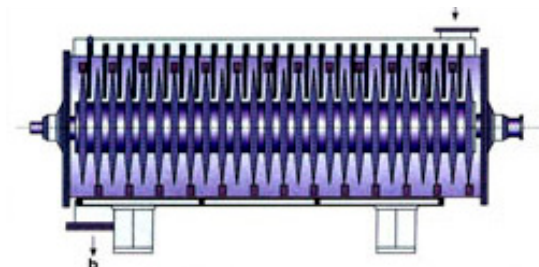
Figure 1. The conventional livestock manure dryer with disc-type.